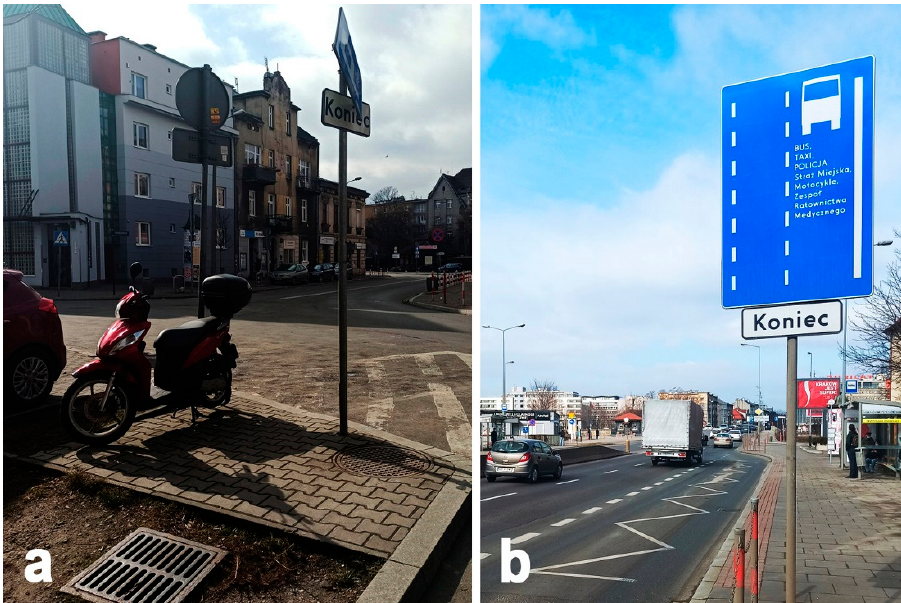
Figure 8. Kraków, Poland: ( a ) Scooter parked on a free fragment of the pavement, ( b ) end of the bus lane with motorbike traffic allowed. Source: Authors’ archives (photo D. Wantuch-Matla).